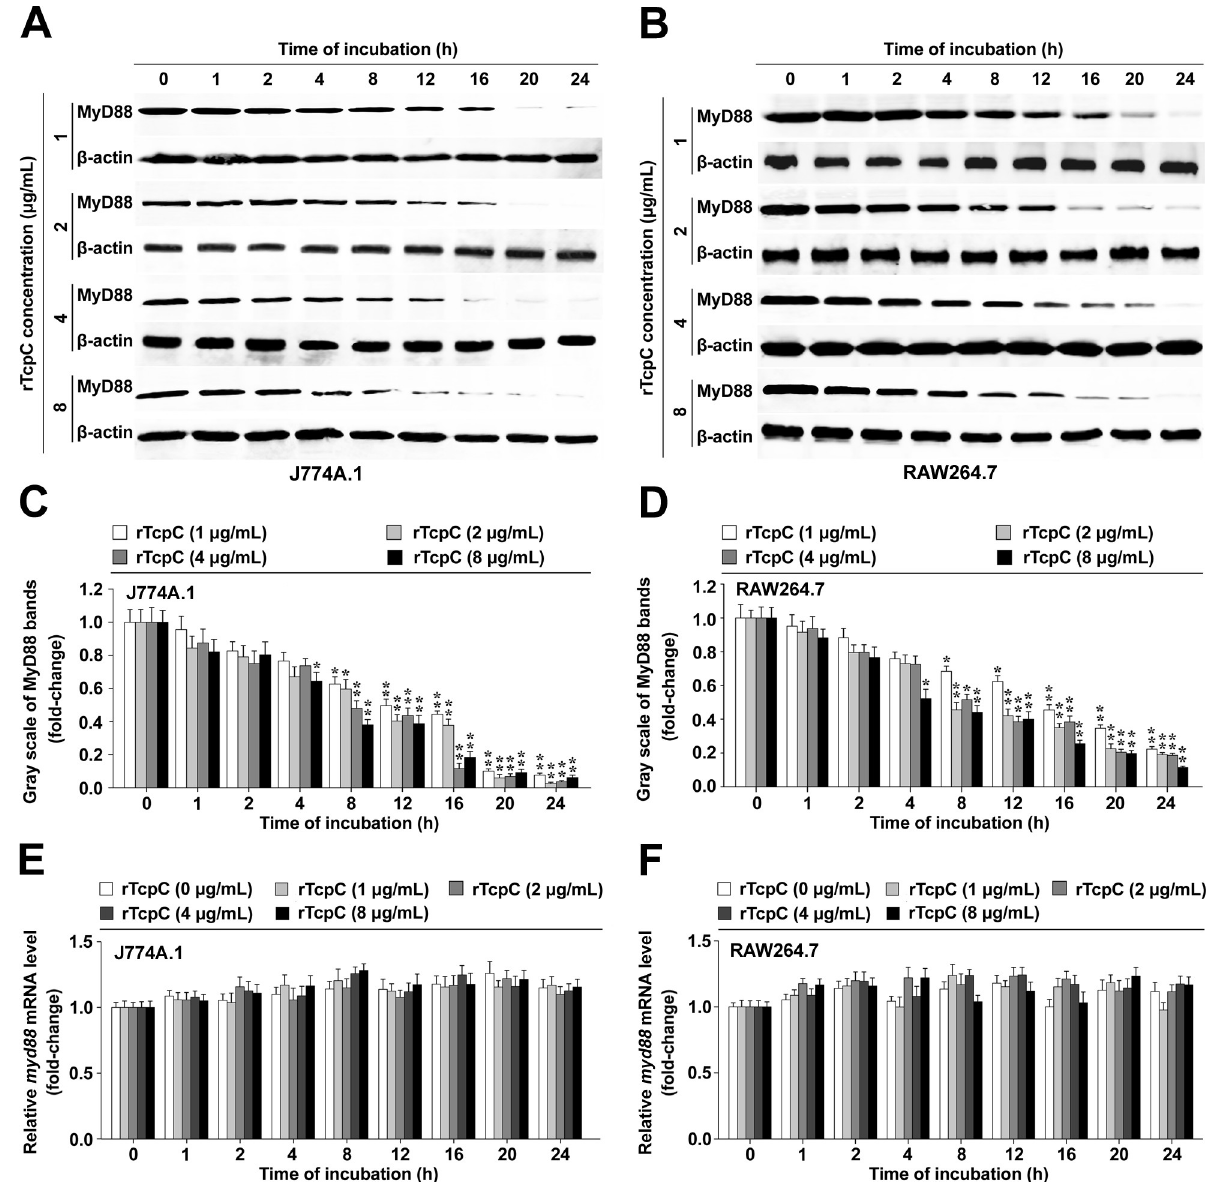
Fig 3. rTcpC dose-dependently inhibits MyD88 protein but not mRNA in J774A.1 and RAW264.7. (A-B) Dose-dependent inhibitory effects of rTcpC on MyD88 protein levels in J774A.1 and RAW264.7 respectively. (C-D) Gray scale analyses of MyD88 bands in different doses of rTcpC treated J774A.1 and RAW264.7. Mean ± SD of three independent experiments were shown. The MyD88 protein levels in cells without rTcpC treatment were set as 1.0. � : p < 0.05, �� : p < 0.01 vs the gray scale values reflecting the MyD88 levels in cells without rTcpC treatment. (E-F) qRT-PCR detection of the influence of rTcpC on myd88 mRNA levels in J774A.1 and RAW264.7, respectively. Mean ± SD of three independent experiments were shown. The myd88 mRNA levels in cells without rTcpC treatment were set as 1.0. enhanced ubiquitination could be abrogated by the E3 ubiquitin ligase inhibitor Nutlin-3 (Fig 4I and 4J). When lysates of the human macrophage cell line THP-1 were used, similar results were also obtained (S4 Fig). These data confirm that TcpC is a MyD88-targeted E3 ubiquitin ligase.